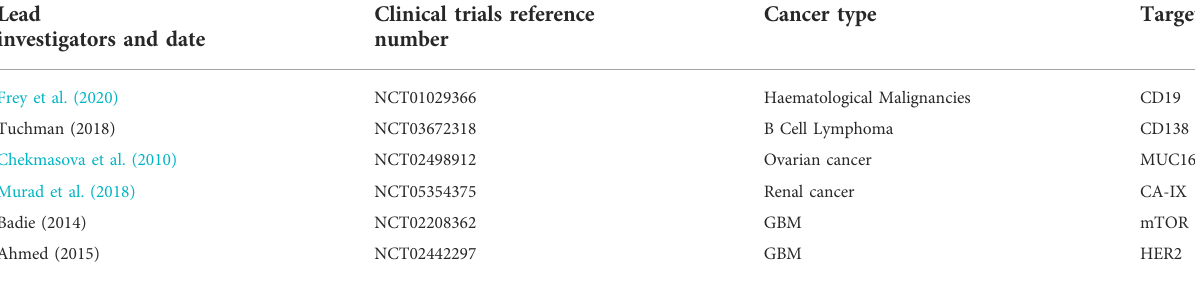
TABLE 1 Information of CAR-T Immunotherapy clinical trial